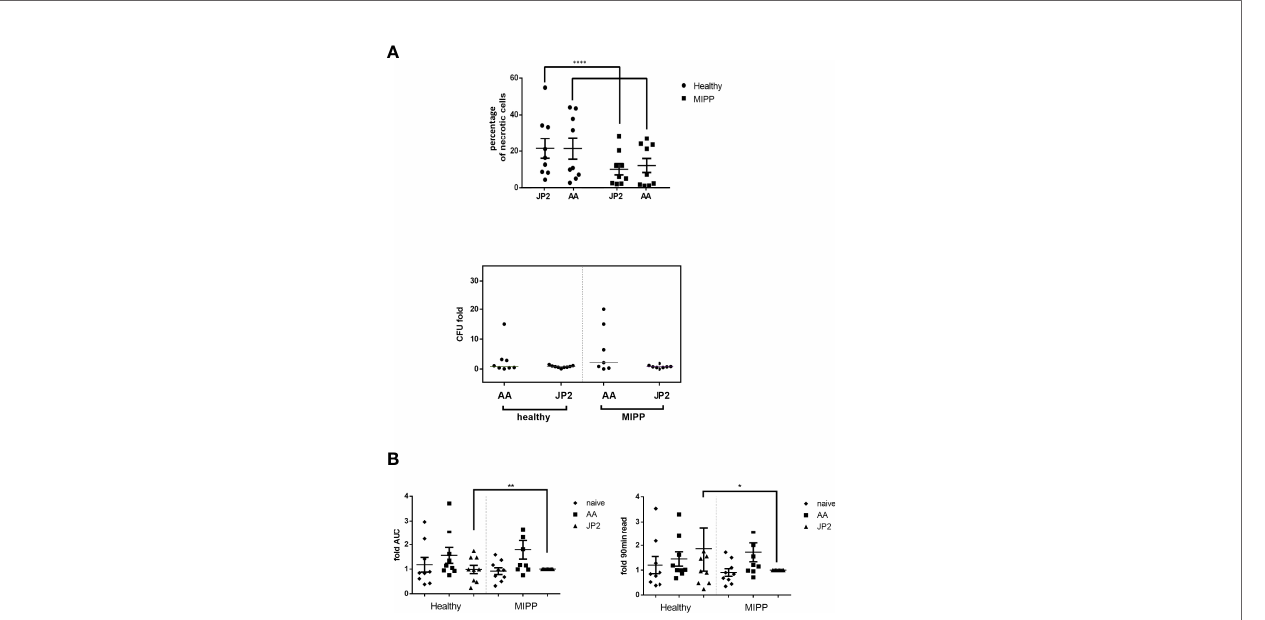
FIGURE 2 | Necrosis and oxidative stress of neutrophils exposed to various bacteria. Neutrophils isolated from 10 periodontally healthy cases and 10 molar incisor pattern periodontitis cases were infected with A. actinomycetemcomitans (AA) or its JP2 clone (JP2). (A) Percentage of necrotic neutrophils (propidium iodide- positive cells in fl ow cytometry analysis). The results are expressed as the mean ± standard error. The horizontal bars represent the median; the T represents standard errors. Each shape represents a different patient. Colony forming units (CFU) as fold-CFU of the same bacterium without neutrophils. The horizontal bars represent the median for each group. (B) Fold-change of area under the curve (AUC) of total oxidative stress (as ROS production) and 90 min after bacterial inoculation. The data are presented as fold- JP2 MIPP as reference. The horizontal bars represent the median; T represents the standard error. The shapes represent the different patients. *P<0.05; **P<0.01; ****P<0.00001.